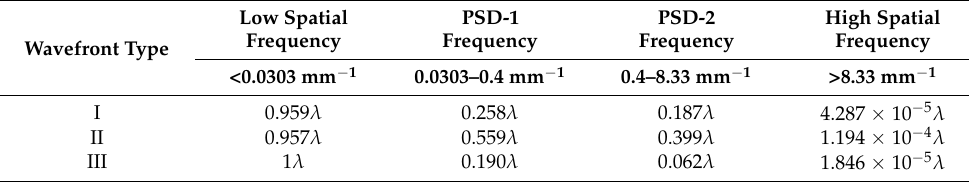
Table 1. PV values of filtered wavefront types when original wavefront PV = 1 λ .